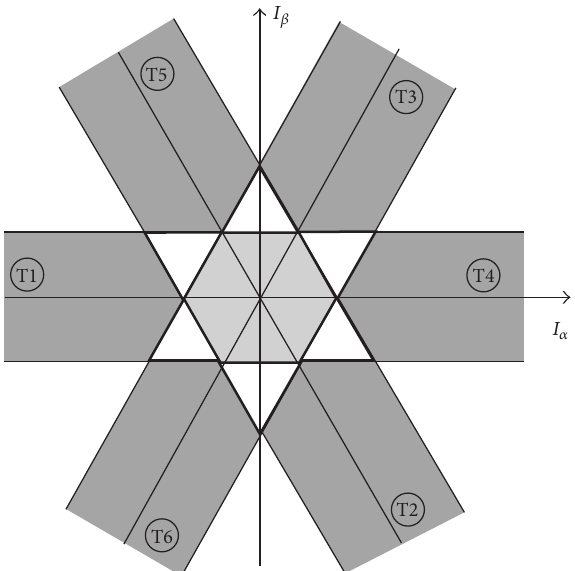
Figure 3: Fault detection and diagnosis